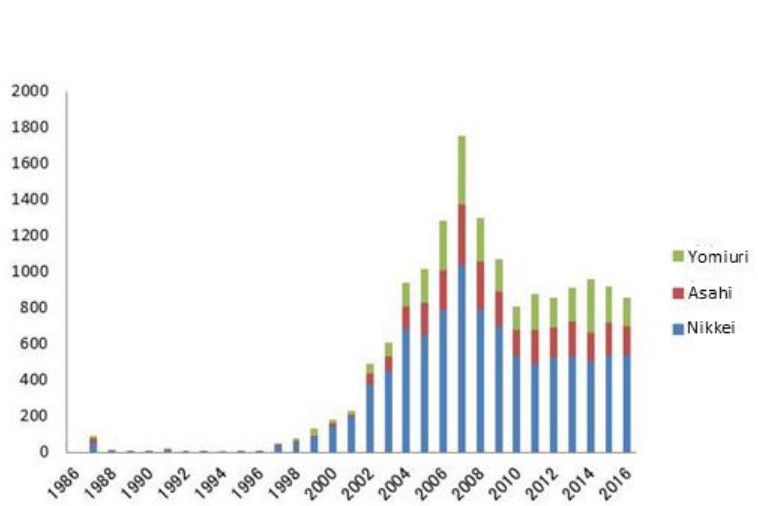
Figure 1. The appearance frequency of “compliance” in